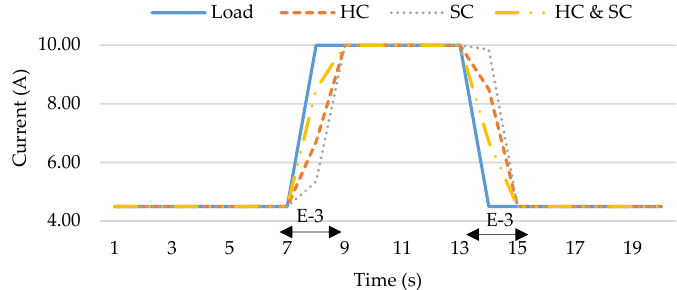
Figure 9. The experimental transient response of the SC bank, HC bank, and parallel arrangement of the SC and HC bank to a constant load current of 4.5 A rising to a pulse of 10 A with a rise time of 1 µs.